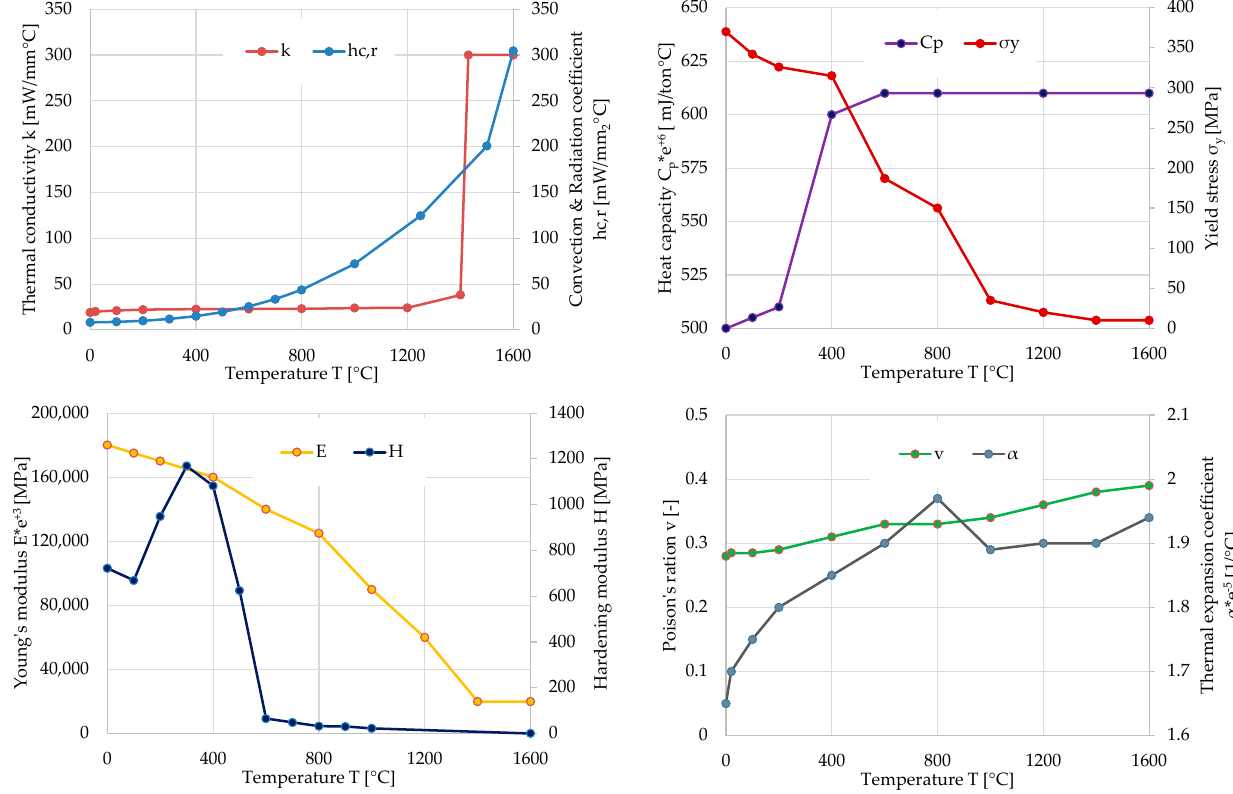
Figure 3. Thermo-mechanical material properties of Steel 309L.